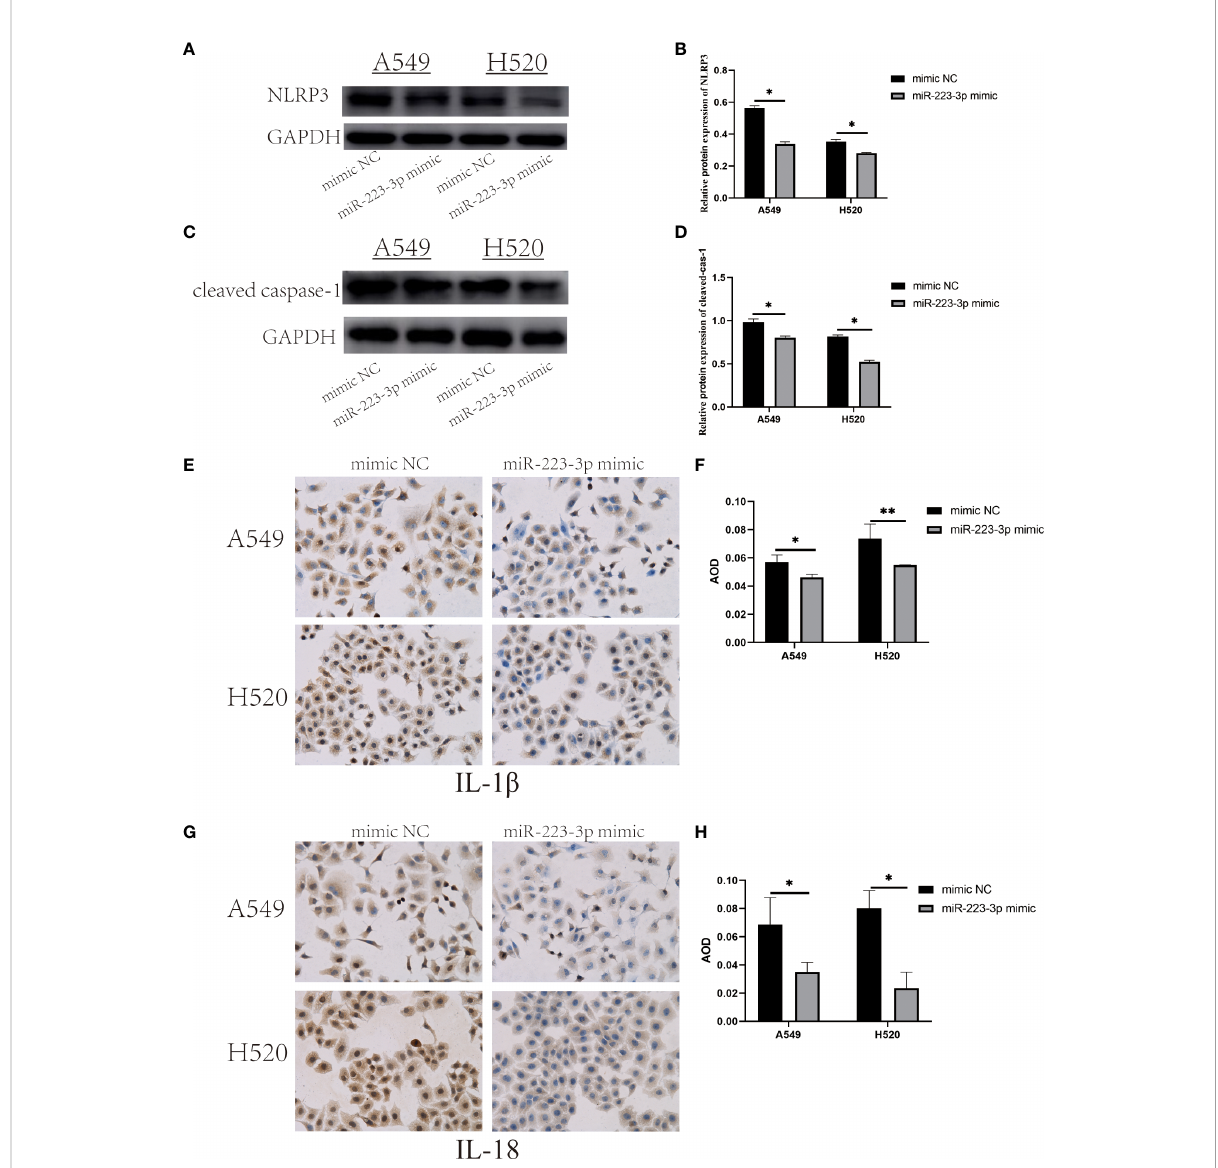
FIGURE 5 Overexpression of miR-223-3p suppressed the expression and activation of NLRP3 in fl ammasome. (A) The expression of NLRP3 protein was observed by Western Blot. (B) Quantitative analysis of NLRP3 protein. (C) The expression of cleaved caspase-1 protein was observed by Western Blot. (D) Quantitative analysis of cleaved caspase-1 protein. (E) Immunohistochemistry analysis (200×) was used to determine IL-1 b protein levels. (F) Quantitative analysis of IL-1 b protein. (G) Immunohistochemistry analysis (200×) was used to determine IL-18 protein levels.